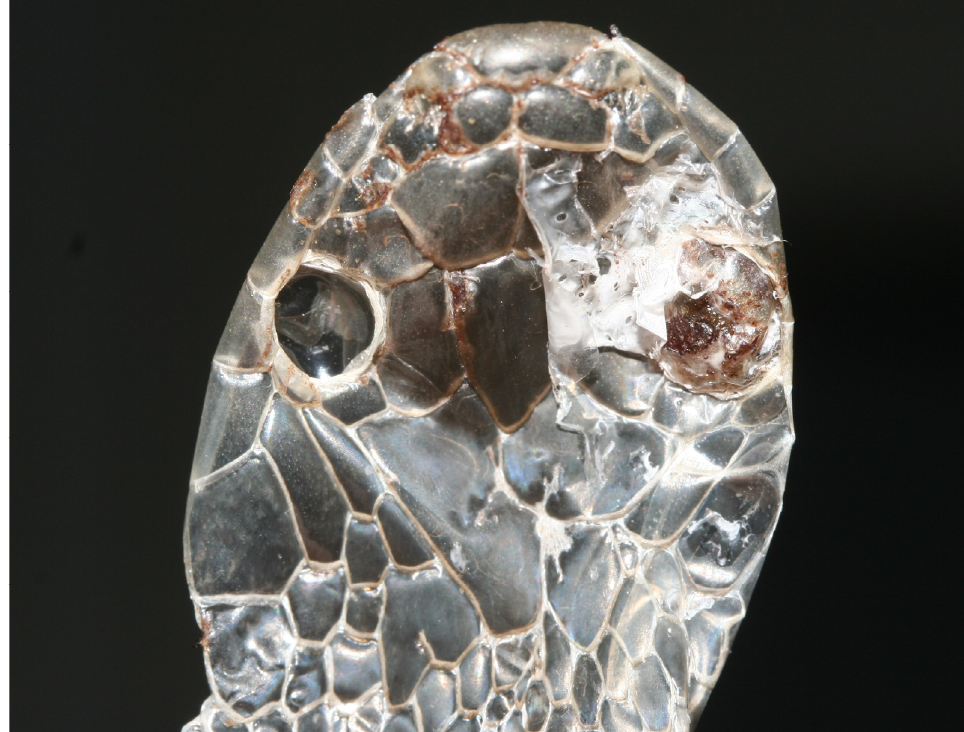
Figure 14. Fresh shed skin from the head of a corn snake ( Pantherophis guttatus ) detached a retained spectacle at the right side.